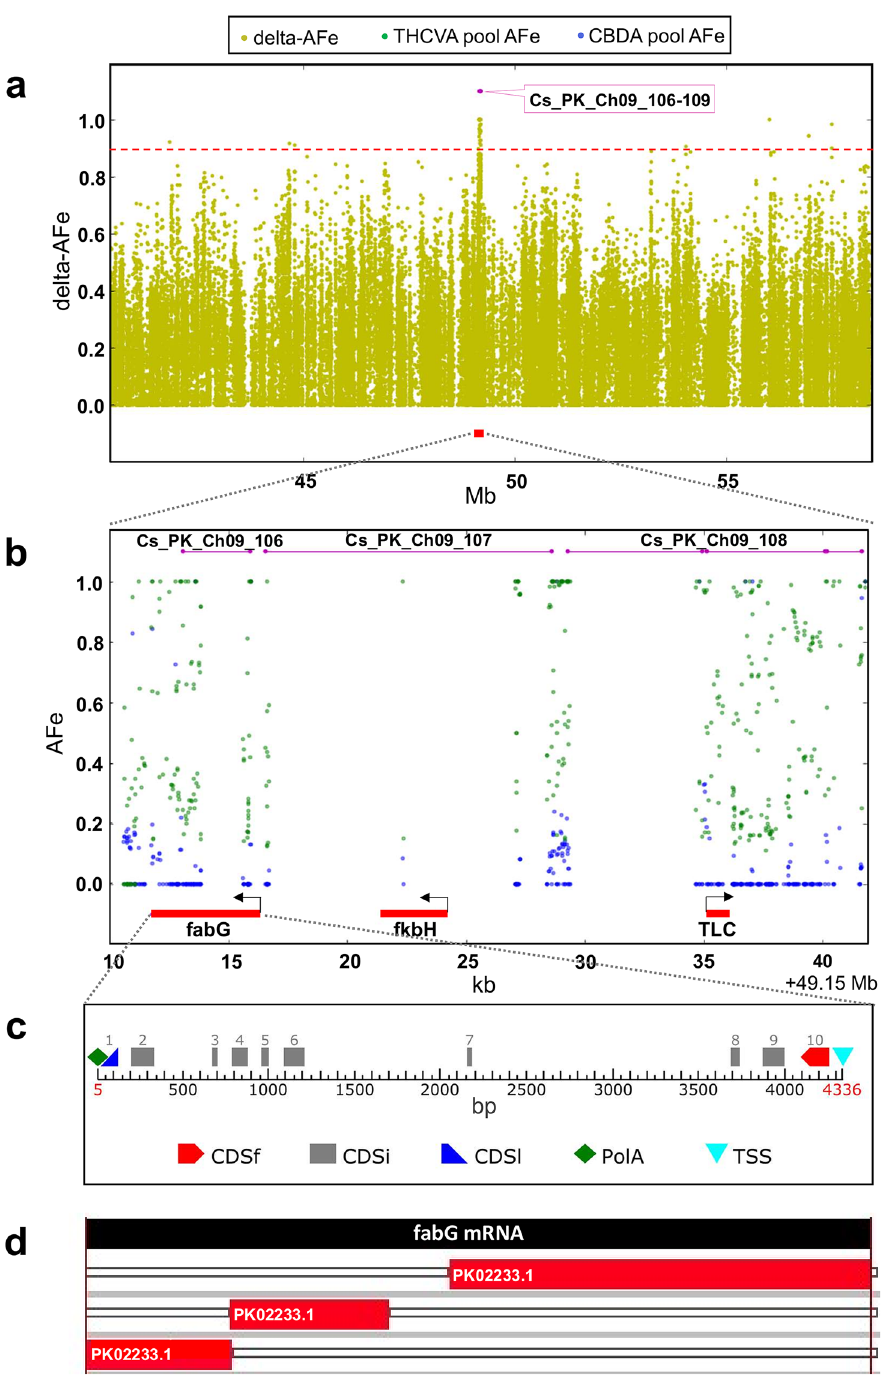
Figure 5. Genomic region encompassing putative candidate alkyl cannabinoid pathway genes. ( a ) Plot of delta-AFe within a region of chromosome nine on the Cannabis sativa L. var. Purple Kush (PK) genome. Red dotted line indicates delta-AFe of 0.9. Pink lines indicate location of intervals. Red line indicates location of putative candidate genes. ( b ) AFe of CBDA and THCVA pools under intervals. Pink lines indicate location of intervals. Red line indicates location of putative candidate genes. Black arrow indicates orientation of gene (+/− strand). ( c ) Positions of exons and gene features for the predicted BKR homolog gene. Gene features: CDSf, first exon including start codon; CDSi, internal exon; CDSl: last exon including stop codon; TSS, transcription start. Graphical output generated using FGENESH (v 2.6) (Softberry, http://www.softb erry.com/berry .phtml ) 87 . ( d ) Alignment of the mRNA sequence of the putative BKR gene homolog with the Purple Kush canSat3 draft representative transcriptome. High scoring alignments were found with segments of the PK transcript PK02233.1 (Supplementary Table S6). Graphic output generated using an in-house TimeLogic DeCypher system (Active Motif Inc., Carlsbad, CA) and TimeLogic Tera-BLASTN algorithm (v2.2.29) (Active Motif Inc., Carlsbad, CA) (https ://www.timel